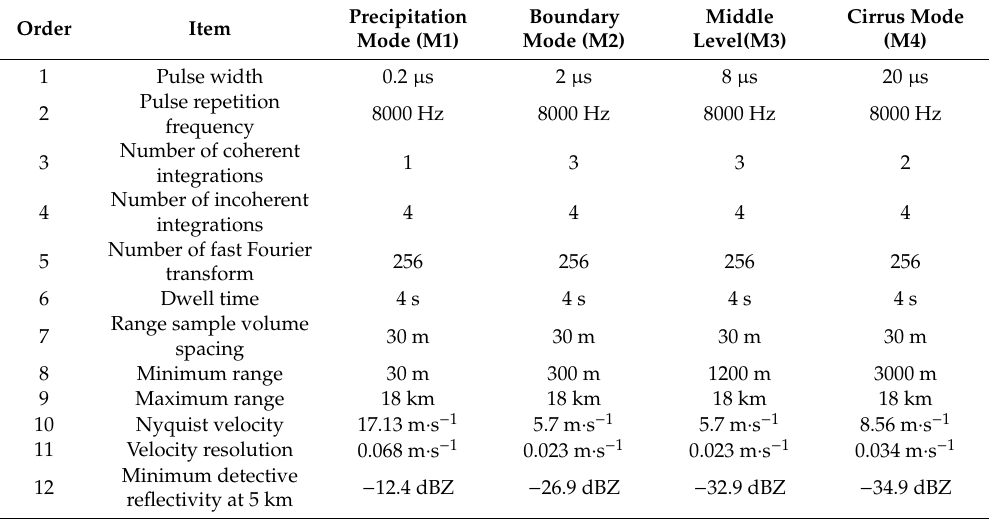
Table 3. Major parameters for the four operational